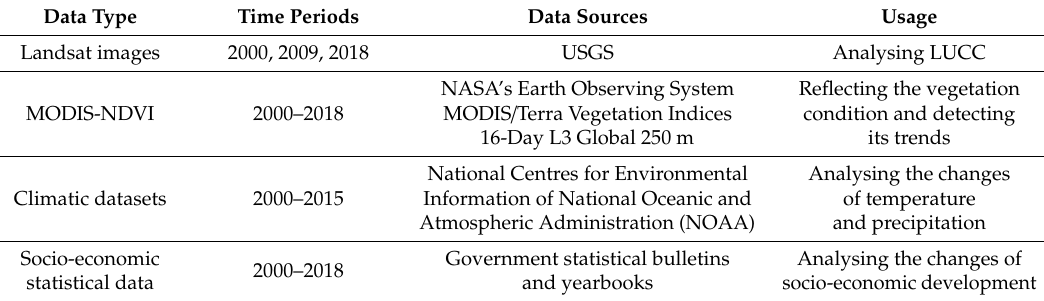
Table 1. Summary of data collection for this study.